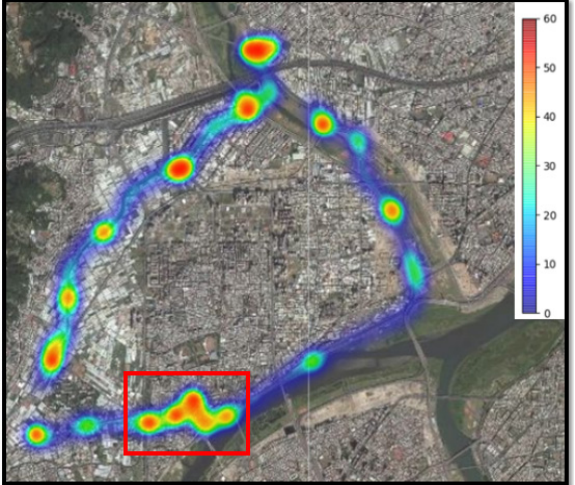
Figure 22. Measured pollutant concentrations at 07:30 P.M. on 15 February 2019.